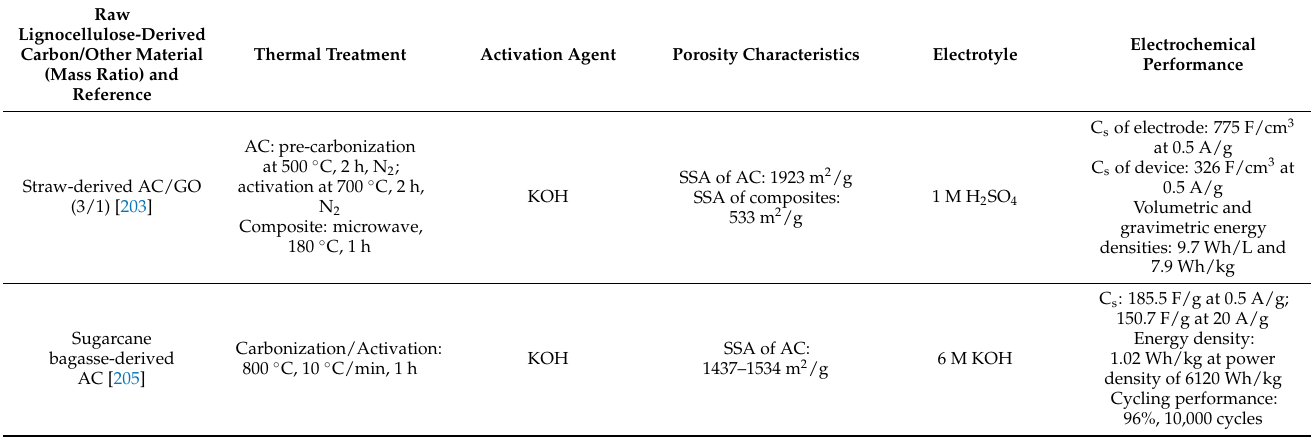
Table 5. Literature summary of flexible supercapacitors based on raw lignocellulose-derived carbon. Raw Lignocellulose-Derived Carbon/Other Material (Mass Ratio) and